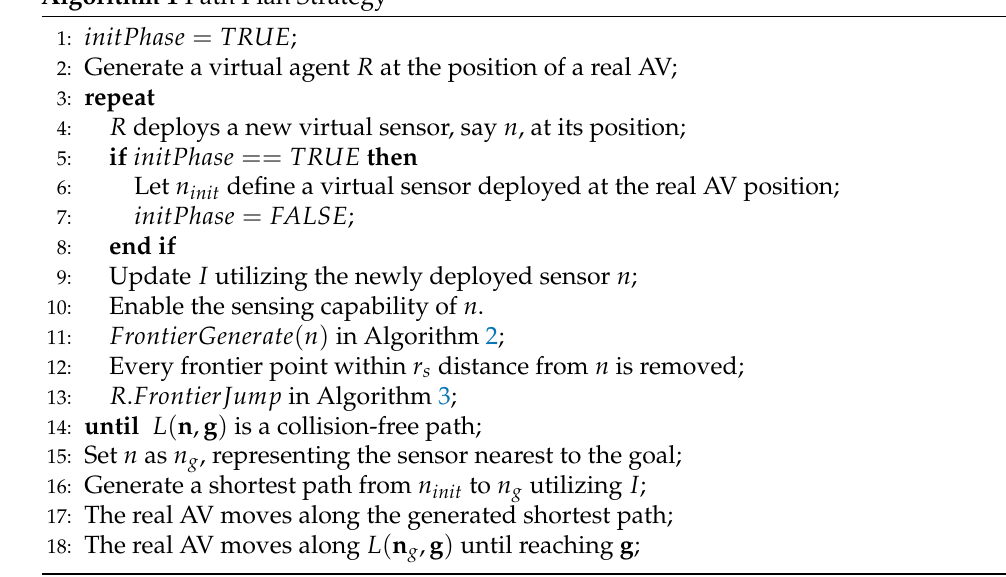
Figure 3. R deploying a new virtual sensor. Frontier points are marked as large dots on the footprint boundary of one sensor. Algorithm 1 Path Plan